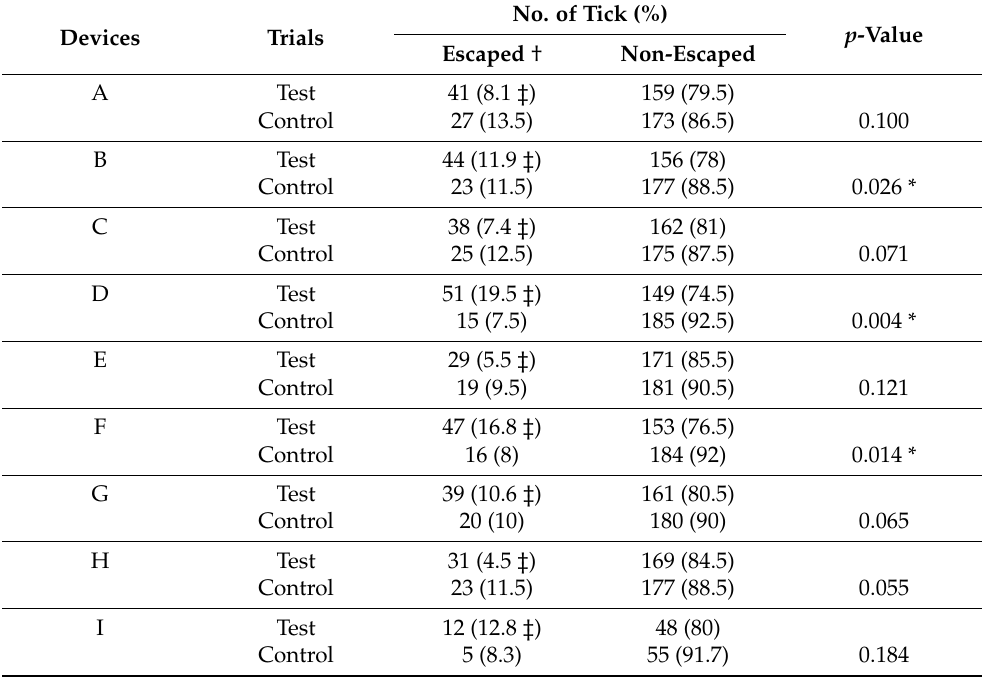
Table 2. The number (and percentage) of escaped (chamber a) and non-escaped (chamber b) ticks after one hour of operating the ultrasonic device and the control (no ultrasonic